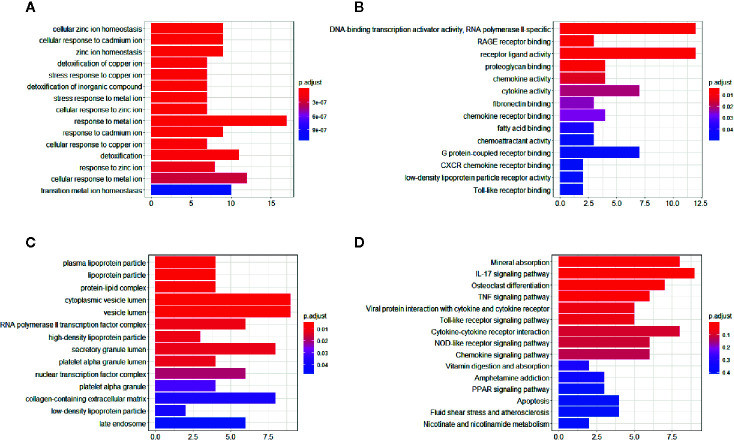
GO and KEGG enrichment analysis of the common DEGs. (A) Significant enriched biological process (BP) in GO terms. (B) Significant enriched cell component (CC) in GO terms. (C) Significant enriched molecular function (MF) in GO terms. (D) Significant enriched KEGG pathway in common DEGs.